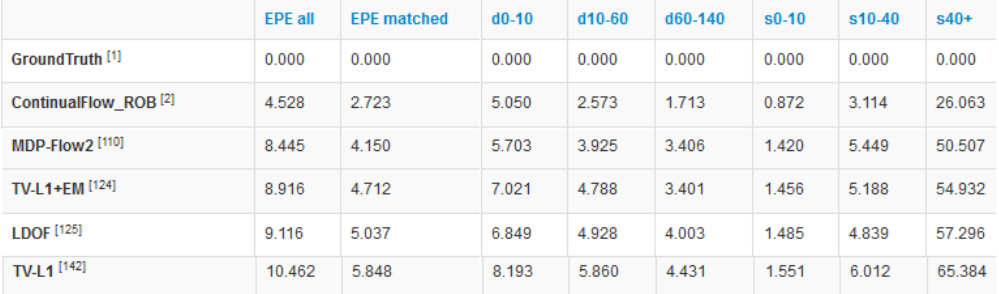
Figure 19. Obtained results by our method in the MPI-Sintel test database (at 18 October